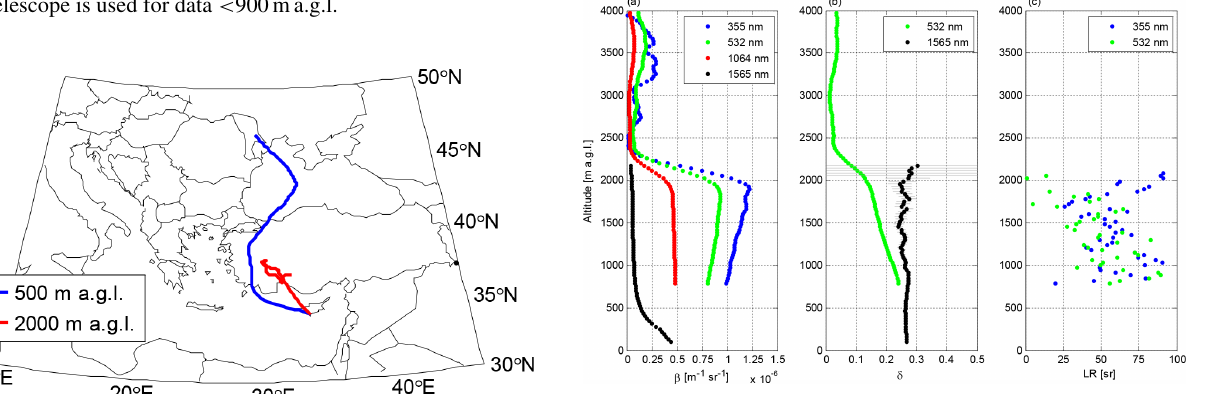
Figure 12. Back trajectories of 96h arriving at Limassol on 20 May 2017 at 21:00UTC. over Limassol at 21:00 UTC indicate different but mostly northerly origins for the air mass at 500 m and at 2 km a.g.l.